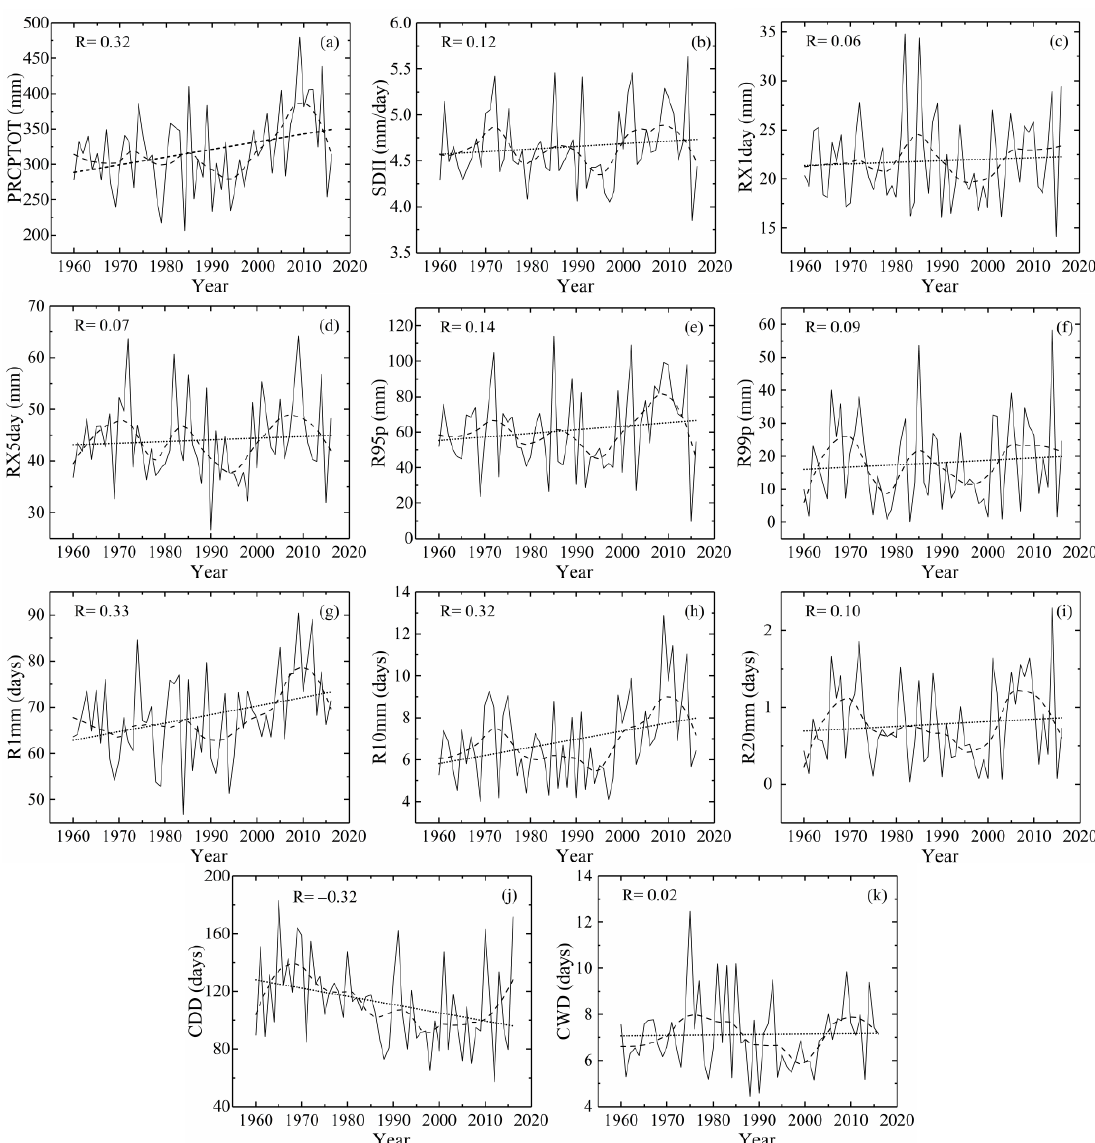
Figure 2. Regionally averaged series for the extreme precipitation indices over the SRYR during 1960 – 2016 for ( a ) PRCPTOT, ( b ) SDII, ( c ) RX1day, ( d ) RX5day, ( e ) R95p, ( f ) R99p, ( g ) R1mm, ( h ) R10mm, ( i ) R20mm, ( j ) CDD, and ( k ) CWD. The dotted line represents the linear trend and R is its correlation coefficient. The dashed line results from locally weighted regression (LOESS) smoothing.